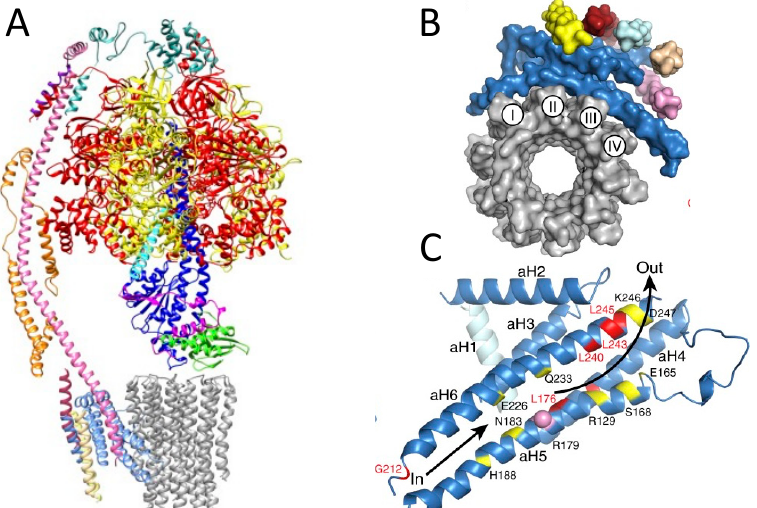
Figure 4. Molecular features of ATP synthase from Pichia angusta (modified from Vinothkumar et al. [47]). ( A ) Structure of the F-ATPase from P. angusta . The α -, β -, γ -, δ -, and ε -subunits forming the membrane extrinsic catalytic domain are red, yellow, royal blue, green, and magenta, respectively; the inhibitor protein is cyan; and the peripheral stalk subunits OSCP, b, d, and h are sea-green, pink, orange, and purple, respectively. In the membrane domain, the c 10 -rotor is grey, the resolved region of the associated subunit a is corn-flower blue. Chains Ch1–Ch4 are pale yellow, brick-red, pale cyan, and beige, respectively, and have been assigned as transmembrane α -helices in subunit f and, in ATP8, as aH1 and bH1, respectively. ( B ) The F-ATPase from P. angusta . The a-subunit (encoded by ATPase6) is corn-flower blue. The c 10 -ring is grey, the b-subunit (upper part not shown) is pink, and the pale yellow, brick-red, light cyan, and beige segments are transmembrane α -helices, Ch1–Ch4 assigned to subunit f, ATP8, aH1, and bH1, respectively. In the c-ring, I–IV indicate the four transmembrane C-terminal α -helices in contact with subunit a. ( C ) The a-subunit viewed from outside and looking out from the interface with the c-ring, respectively, with aH1 in pale cyan. Conserved polar residues are yellow; the positions of human mutations associated with pathologies are red. L176 in the cartoon correspond to the L156 (Leu156) mutated in the NARP mutation (either into an Arg or into a Pro). The pink sphere denotes the conserved Arg179 in aH5 that is essential for proton translocation and corresponds to human R159 residue (see text). The lower arrow indicates the inlet pathway for protons that transfer to Glu59 in the C-terminal α –helix-II of the c-ring. They are carried around the ring by anticlockwise rotation, as viewed from above, until they arrive at Arg179 where they enter the exit pathway (upper